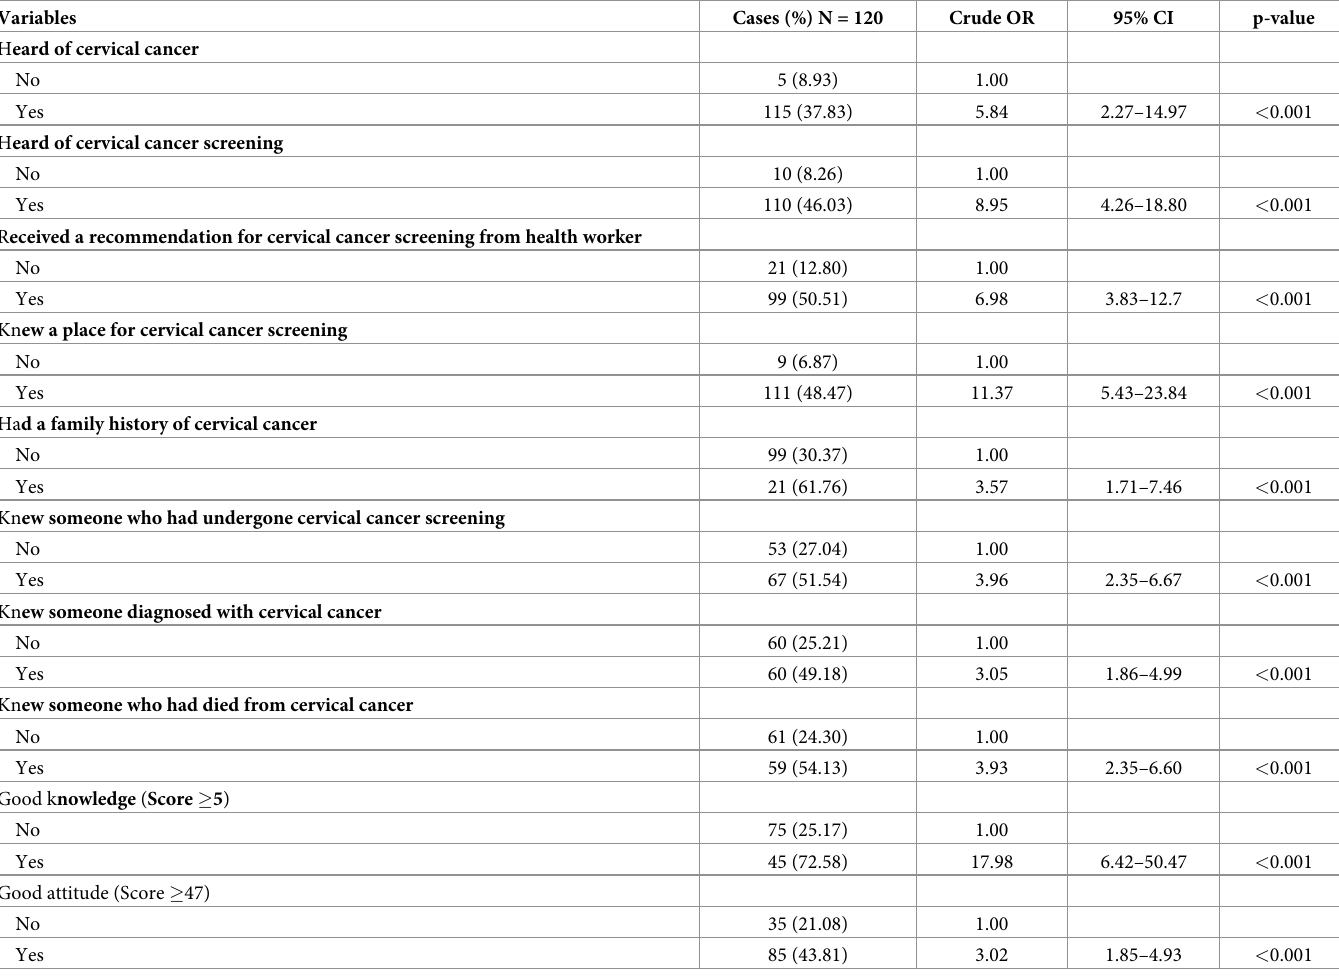
Table 2. Bivariate analyses of an association between cervical cancer screening and participants’ perception, knowledge and attitude.